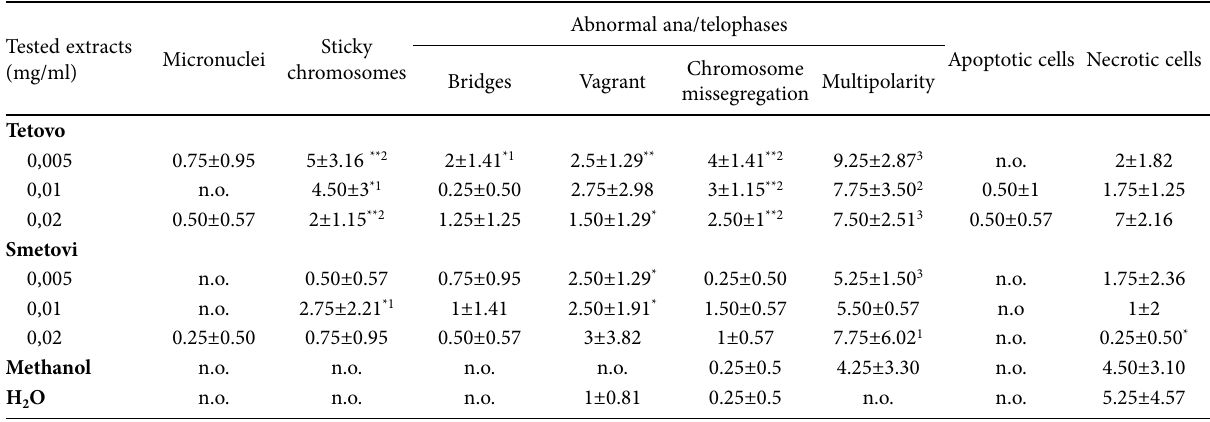
Table 3 The results of the genotoxicity and cytotoxicity in Allium cepa (mean ± SD) exposed to various concentrations of the P. major extract.